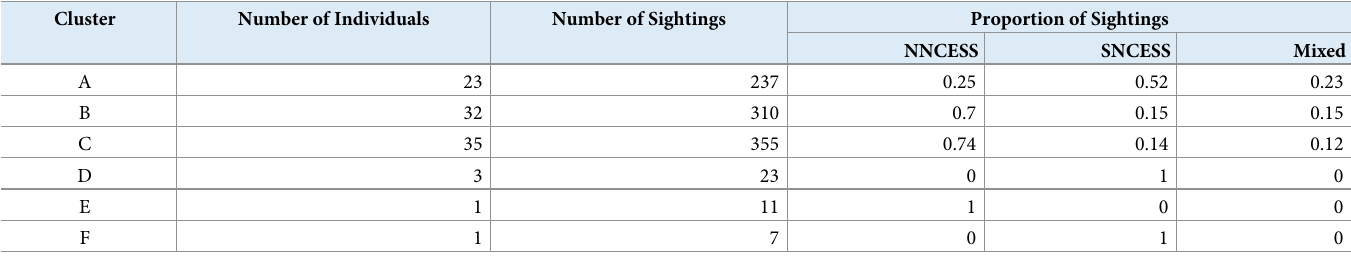
The proportion of sightings of individuals within each cluster that occurred within the defined stock areas for NNCESS, SNCESS, or the mixed-stock